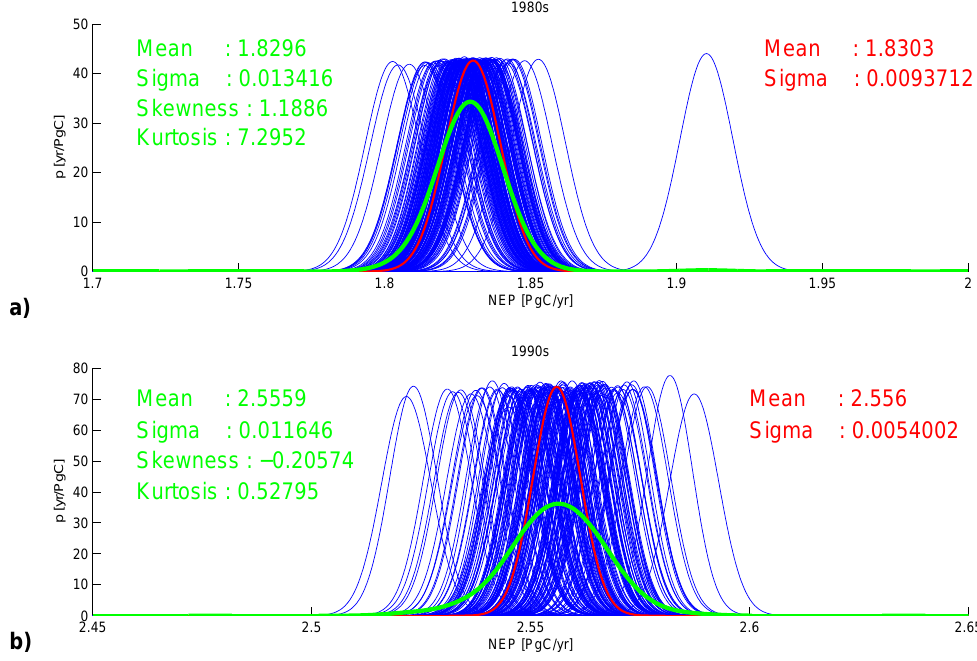
Fig. 3. PDFs for global NEP for (a) the 1980s and (b) the 1990s. Blue: 170 individual PDFs, red: base case PDF (which used prior photosynthesis parameters and was not part of the ensemle), green: superimposed PDF from the 170 individual PDFs.